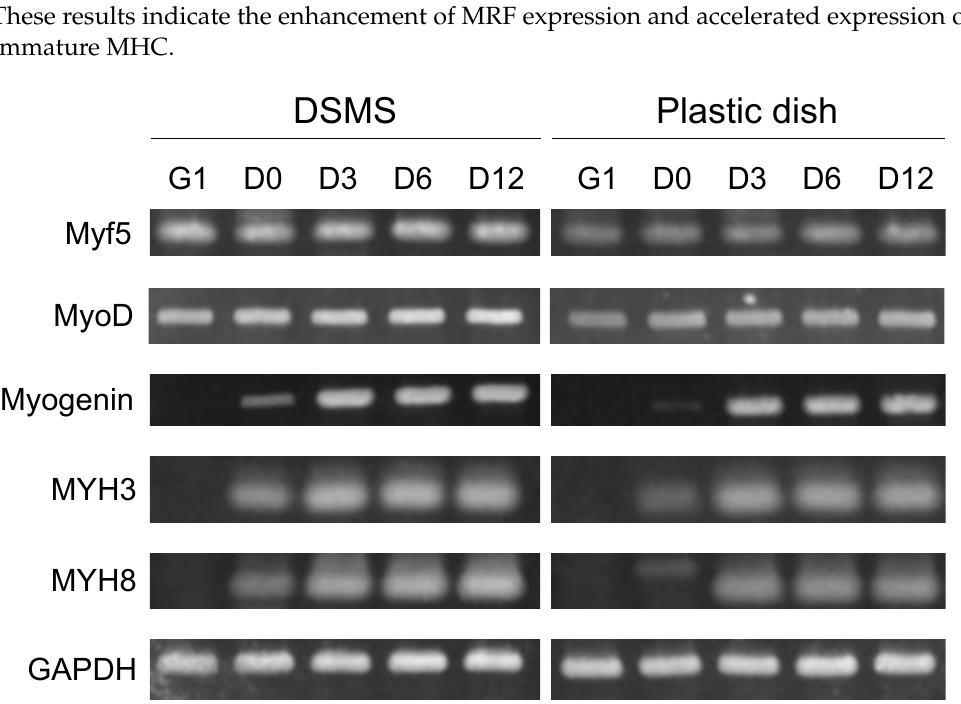
Figure 4. Semi-quantitative reverse transcription-polymerase chain reaction of gene expression involved in myocyte differentiation. G1, Growth day 1. D0–D12, differentiation 0–12 days. DSMS, decellularized skeletal muscle sheets.